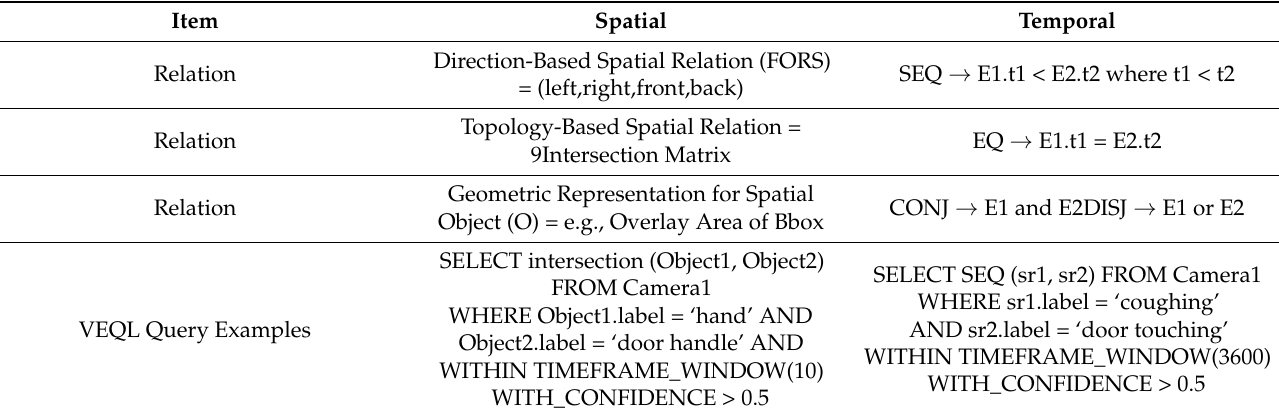
Table 1. Sample spatial/temporal relationships and